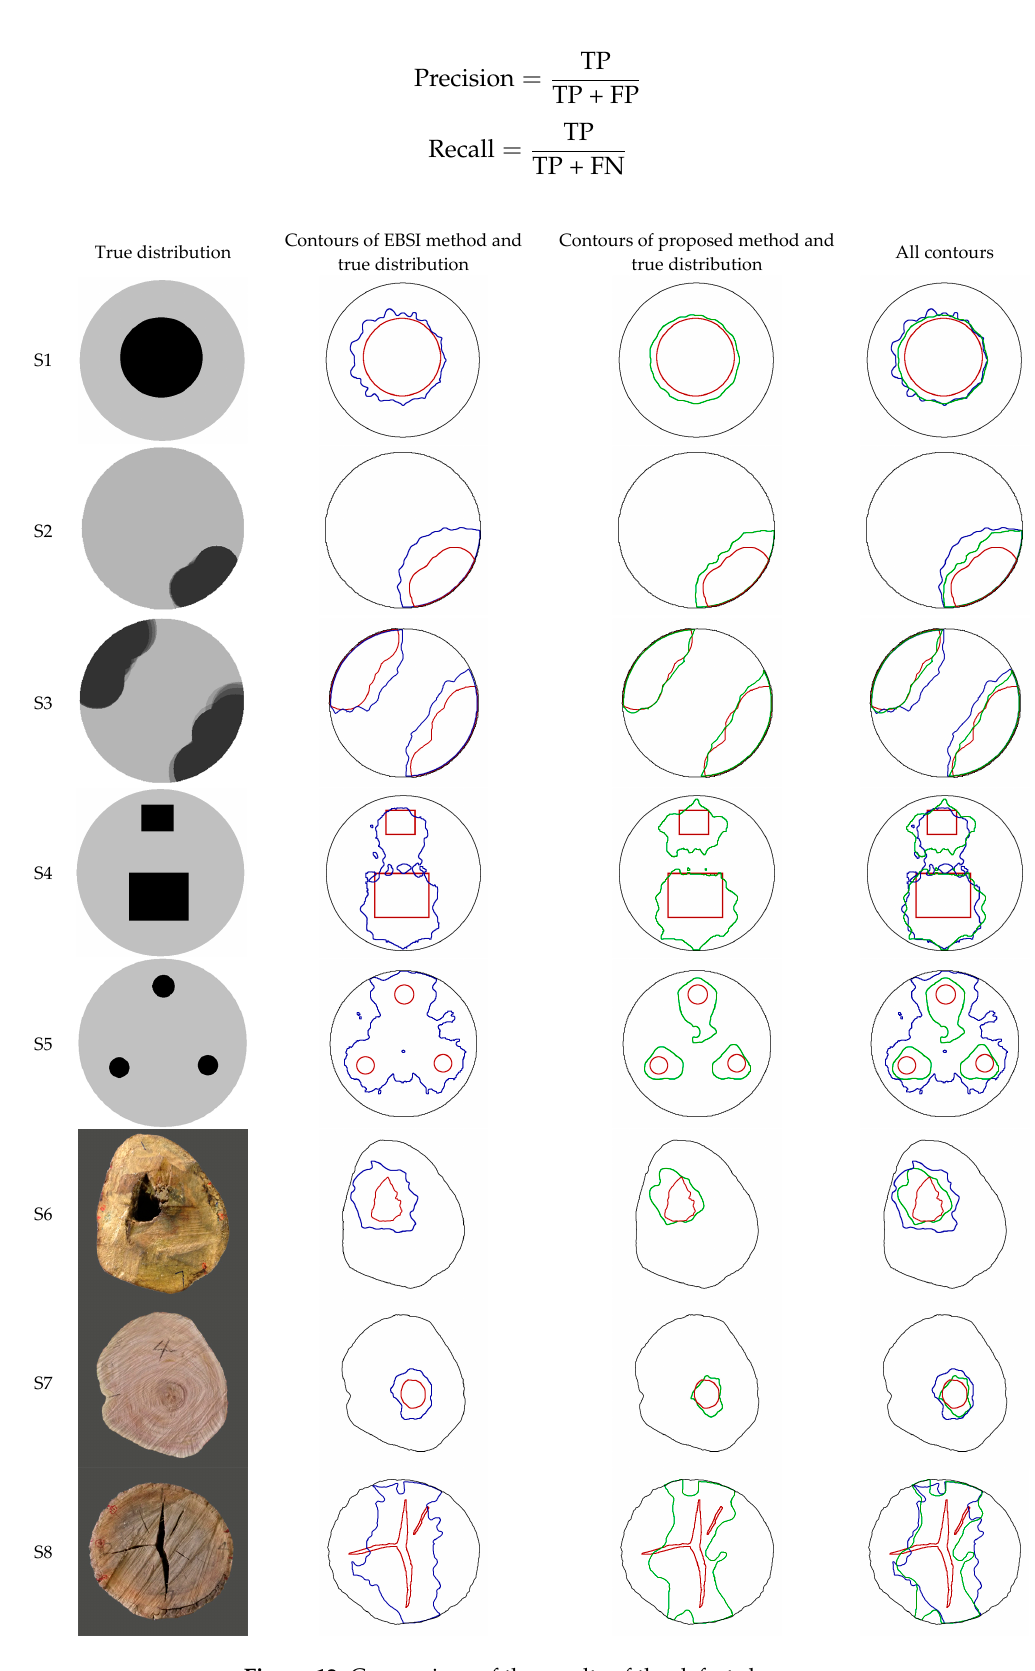
Figure 12. Comparison of the results of the defect